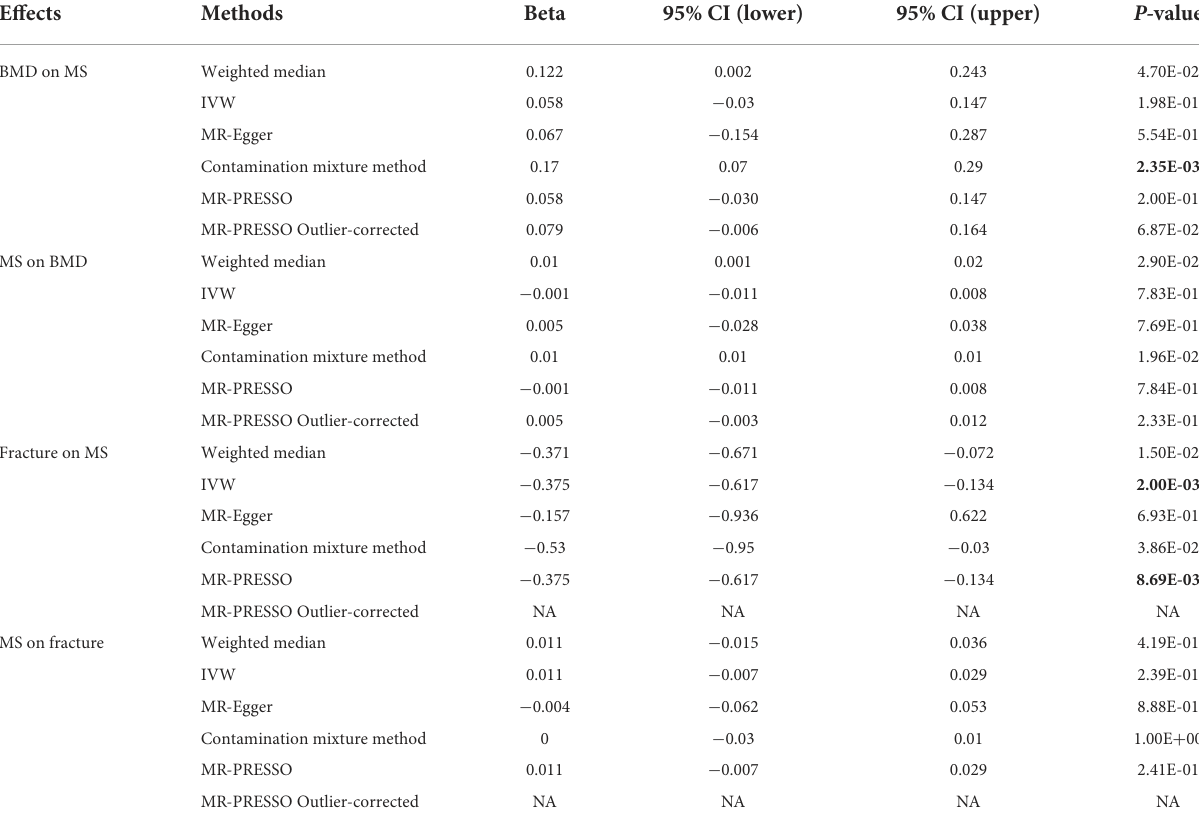
TABLE 3 An MR analysis results about the causal association of bone mineral density (BMD) and fracture with multiple sclerosis (MS).